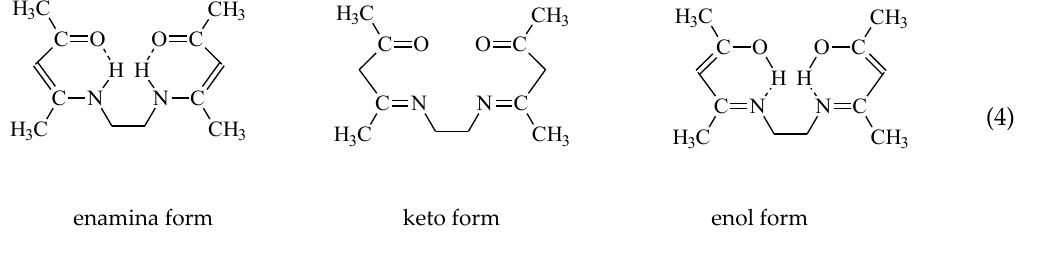
Figure 7. Scheme of EDAB-acac -metal ion complexation. Table 4. Initial fluxes, order and separation coefficients for competitive transport of Zn(II), Cr(III) and Ni(II) ions through membrane doped with EDAB-acac. Conditions as in Figure 6.